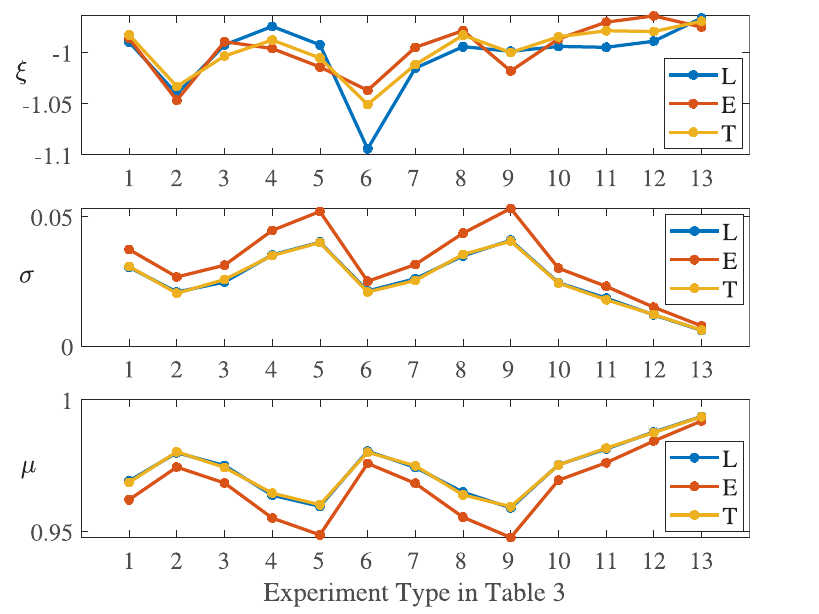
Fig 8. Parameters estimated of experiments in Table 4.